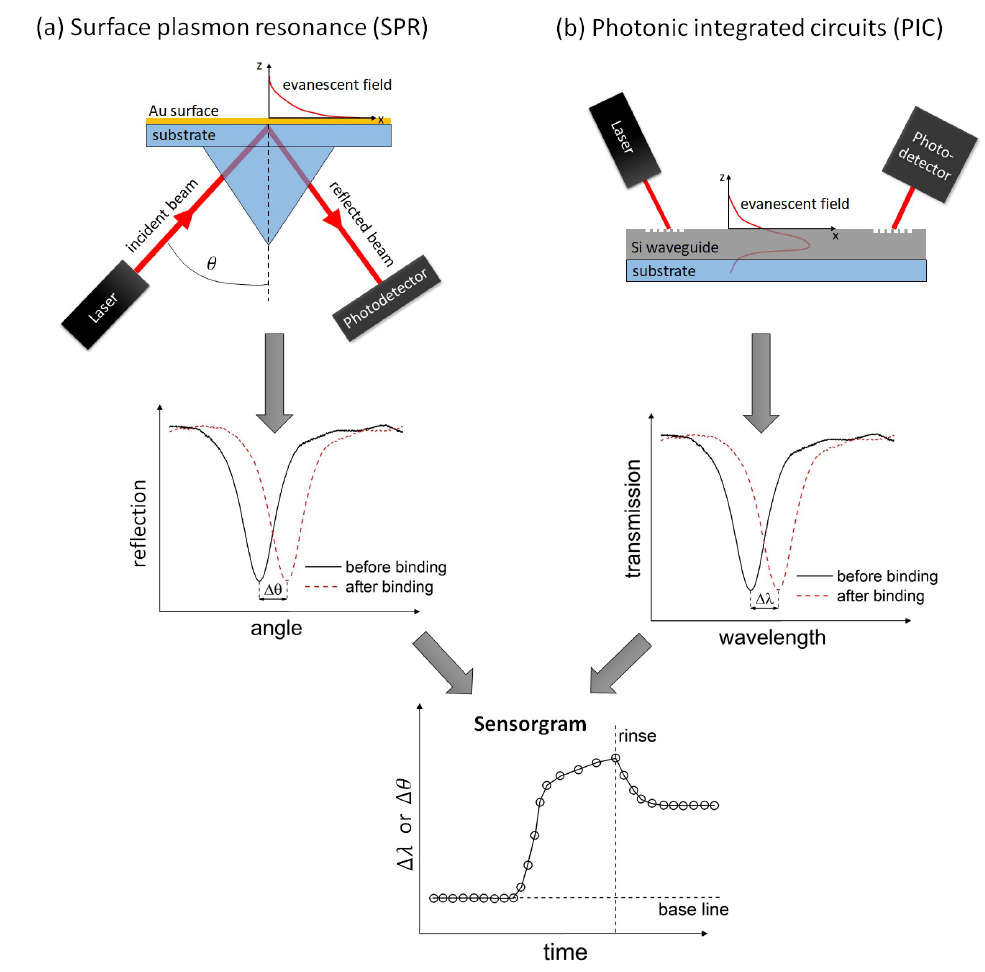
Figure 1. ( a ) System architecture of a SPR instrument. Sweeping the angle θ leads to a resonance peak in the reflection spectrum. ( b ) The principle system architecture of PIC biosensors is shown. Sweeping the laser wavelength leads to a resonance peak in the transmission spectrum (see Section